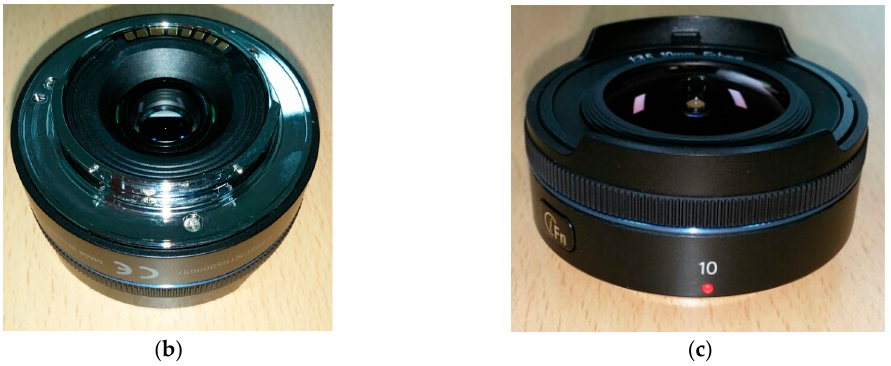
Figure 3. ( a ) Optical layout of the optimized fisheye lens system and ( b ) top and ( c ) bottom views of the fabricated fisheye lens system.